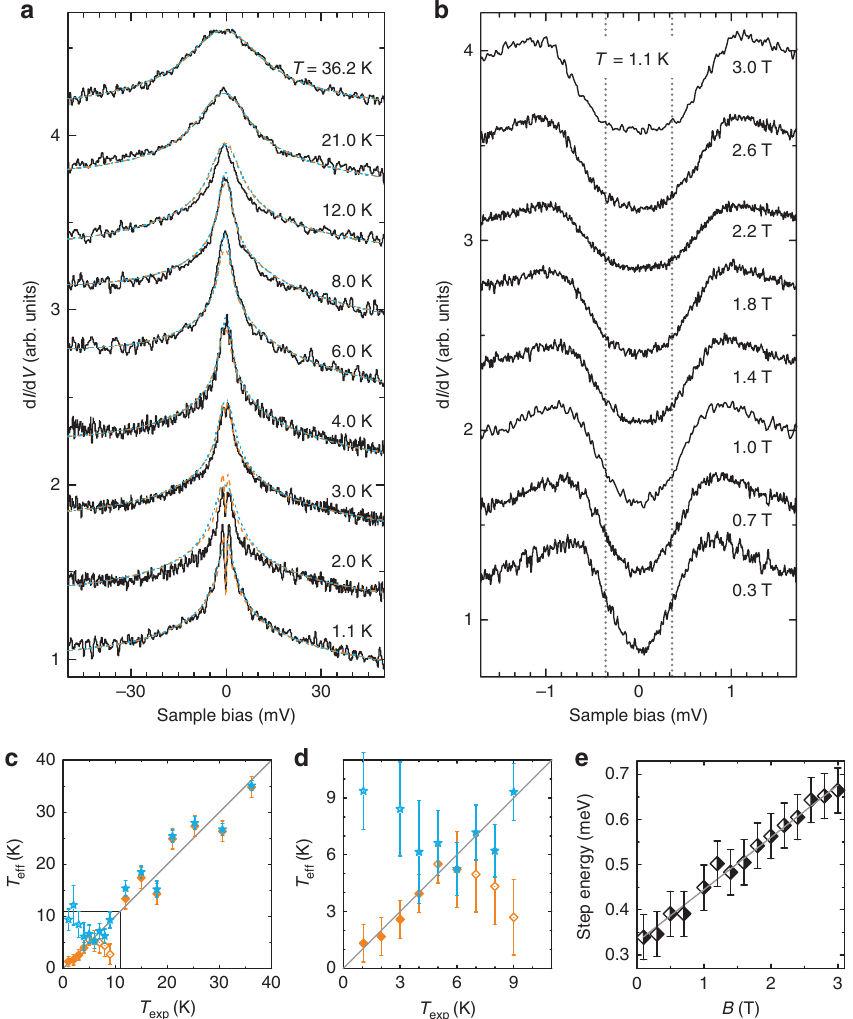
Fig. 3 Temperature and B - fi eld dependence of the Kondo resonance. a Temperature evolution of the zero-energy resonance at B = 0.1 T, which quenches the superconductivity in the sample (50 mV, 200 pA, 500 μ V rms ). The spectra are offset for clarity. A split zero-energy resonance is observed. Orange (blue) lines are fi ts according to the third-order scattering model as described in refs. 15, 16 including (excluding) uniaxial magnetic anisotropy as determined in ( e ). b Evolution of the step-like feature around E F in an external B fi eld parallel to the surface normal (5 mV, 200 pA, 50 μ V rms ). c , d Effective temperature T eff as extracted from fi ts like in ( a ) versus the experimental temperature T exp . Orange squares (blue stars) are from fi ts accounting for (disregarding) the axial anisotropy as determined in ( e ). e Step energies versus B . Energies are extracted from the d I/ d V spectra in ( b ) by a least-squares fi t with symmetric step functions. The gray line indicates the fi t to a Spin Hamiltonian for S = 1 with uniaxial anisotropy: D = − 0.33 ± 0.01 meV; g = 2.03 ± 0.07. All spectra were acquired with a normal metal Au tip. Error bars in c – e account for the standard error on the least-squares fi t